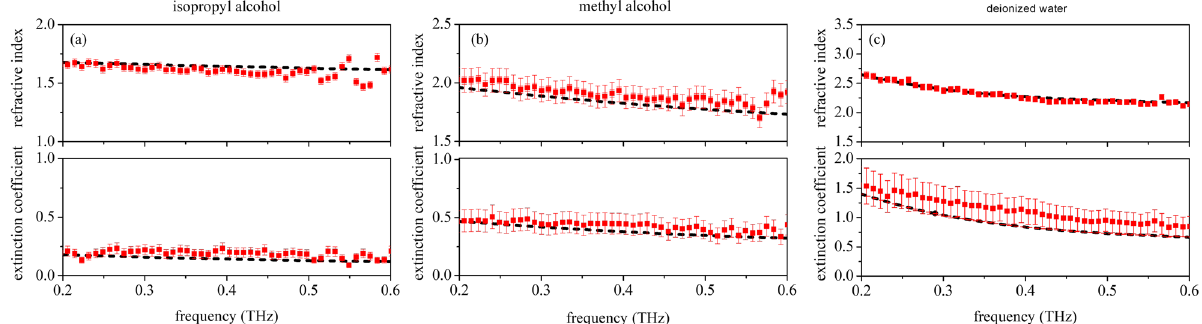
Figure 7. Complex refractive index of ( a ) isopropyl alcohol, ( b ) methyl alcohol, and ( c ) water. Ellipsometric data are shown as red full circles, whereas black dashed lines represent the results of standard TDS measurements using the ellipsometer